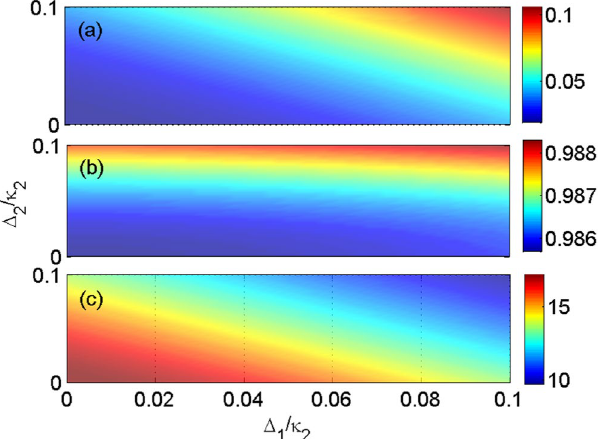
Figure 4. The dependence of nonreciprocal behaviour on frequency detunings. For the off-resonant case, the transmission coefficients ( a ) T L and ( b ) T R , and ( c ) isolation ratio vary with frequency detunings Δ 1 / κ 2 and Δ 2 / κ 2 . The other system parameters are chosen as γ = 0.17 κ 2 , κ 1 = − 7.4 κ 2 , κ e = 3.2 κ 2 , J = 0.8 κ 2 , ε